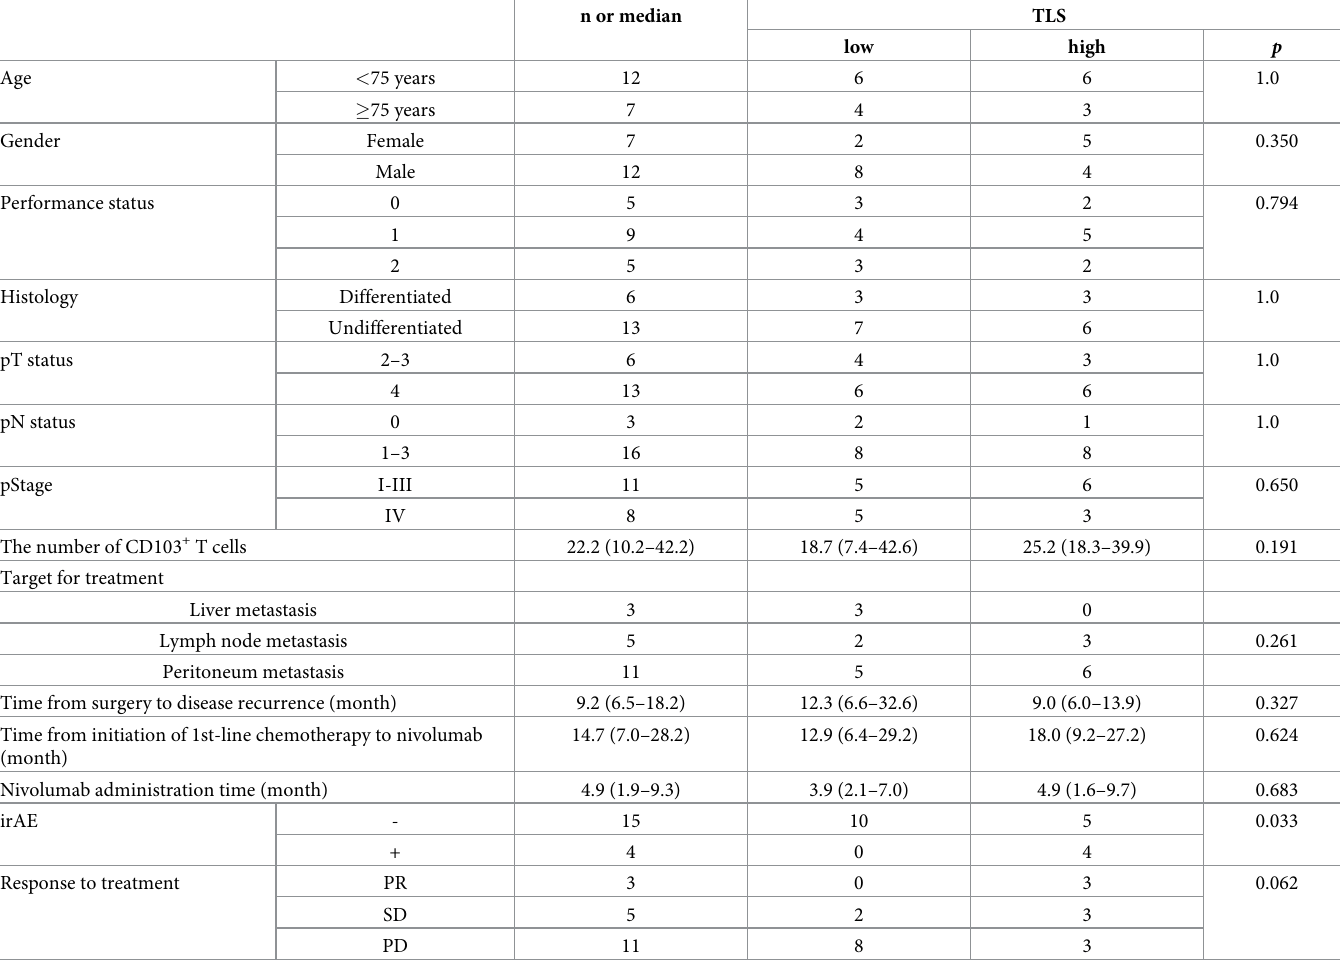
Table 1. Correlations between clinicopathological factors and Tertiary Lymphoid Structures